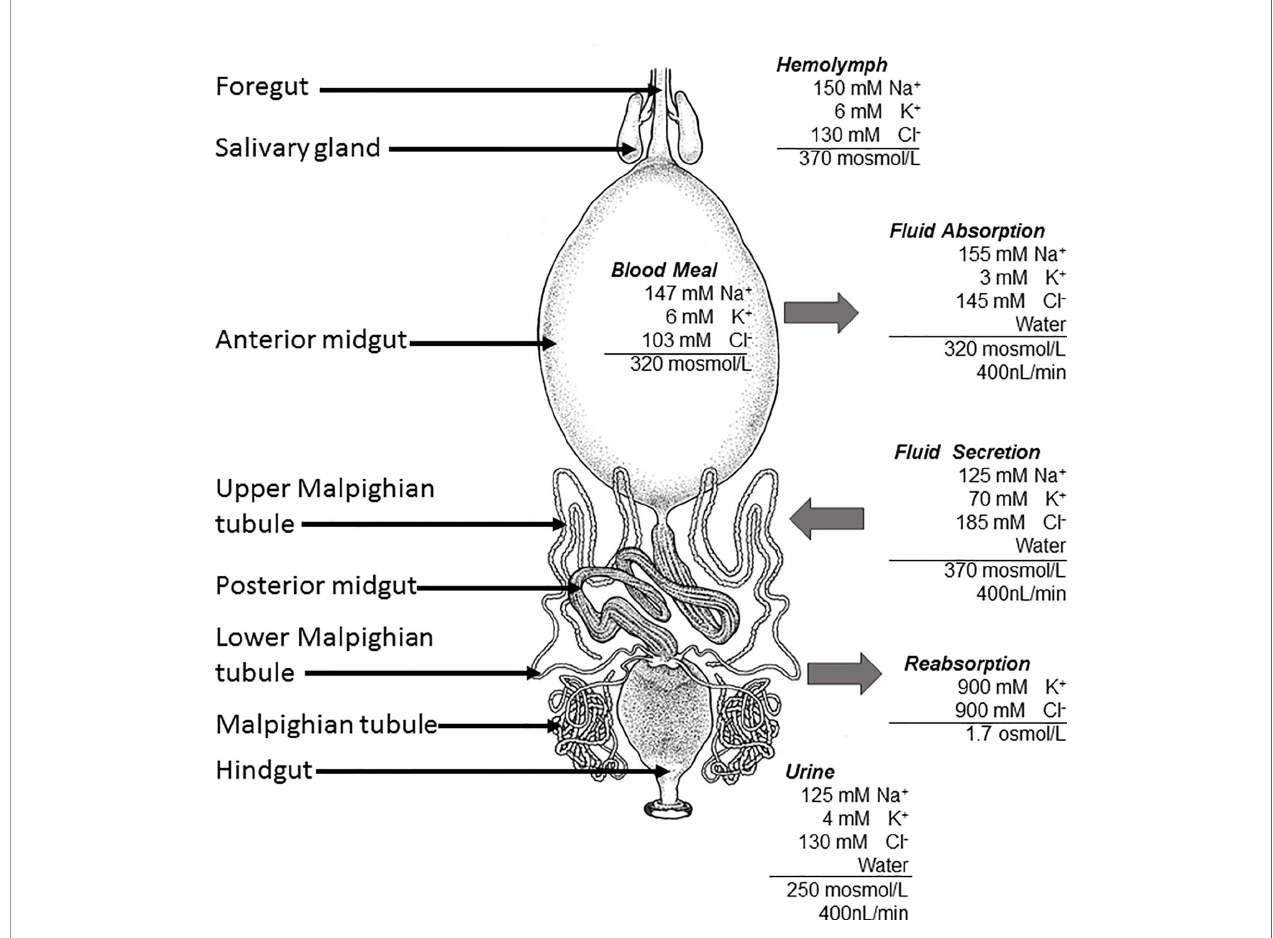
FIGURE 2 | The digestive system of Rhodnius prolixus , including the tissues involved in diuresis. The ionic composition of the blood meal and hemolymph are shown, and arrows indicate movement of water and ions during post-prandial diuresis. Primary urine is eliminated via the hindgut (data taken from